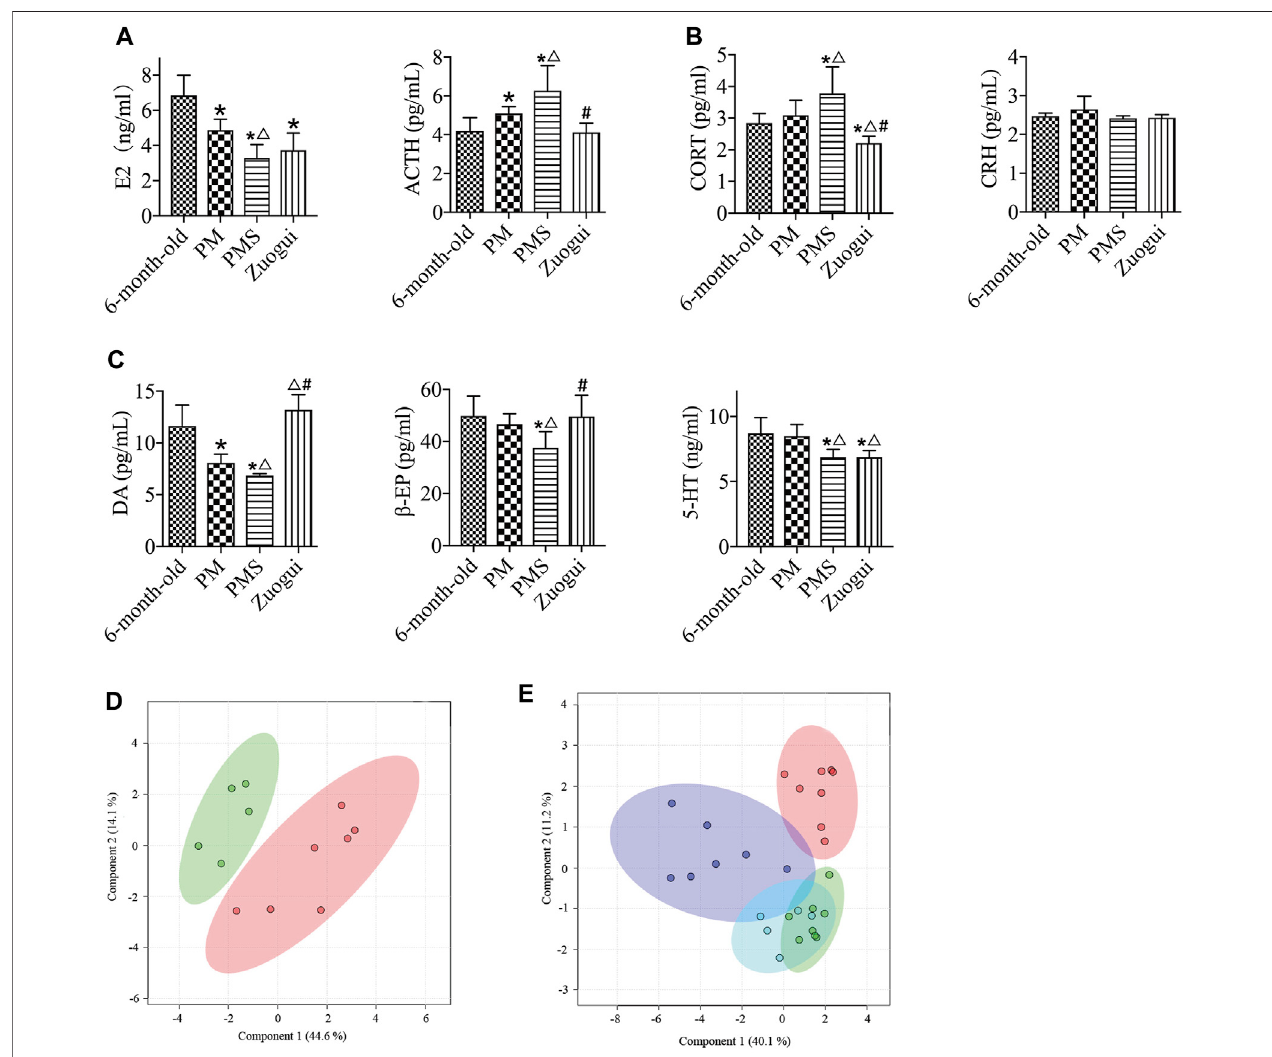
FIGURE 5 | Zuogui regulated the levels of metabolites and endocrine indexes in PMS rats. (A) The E2 levels of PMS rats treated Zuogui were not signi fi cantly different. (B) The levels of ACTH and CORT of PMS rats were reduced after the treatment with Zuogui. (C) The levels of DA and β -EP in PMS rats were enhanced after beingtreatedwithZuogui. (D) PLS-DAanalysisofmetabolomicspro fi lesforPMSratstreatedwith(green)andwithoutZuogui(red). (E) Metabolomicpro fi lesofPMSrats (purple), PMSratstreated withZuogui(blue),perimenopausalrats(green),and 6-month-oldrats(red). “ * ” indicates thecomparisonwith6-month-oldrats[ p < 0.05(*)]; “ △ ” indicates the comparison with perimenopausal rats [ p < 0.05 ( △ )]; “ # ” indicates the comparison with PMS rats [ p < 0.05 (#)].